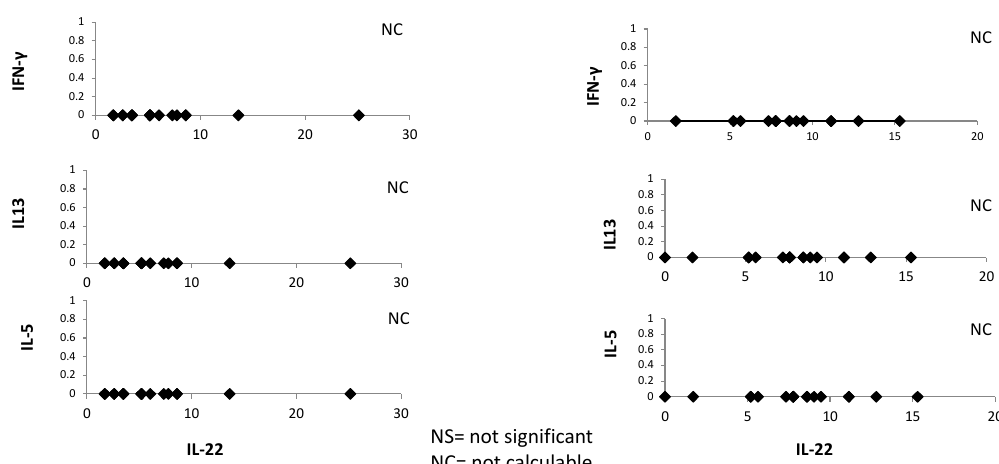
Figure 3. In the serum of successful pregnancy, IL-22 is positively correlated with IL-4. The levels of IL-22, IL-4, IFN- γ , IL-5, IL-13, and IL-17A were measured with a multiplex bead-based assay in the serum of 18 women with successful pregnancy and 18 unexplained recurrent abortion (URA) patients, and these levels were correlated.